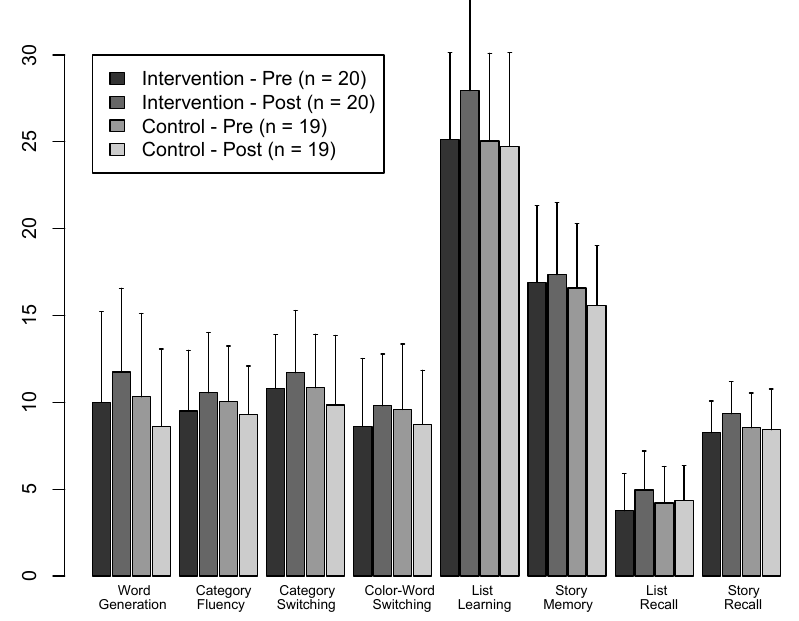
Figure 4. Mean scores on neurocognitive functioning for treatment and wait-list control, pre- and post-